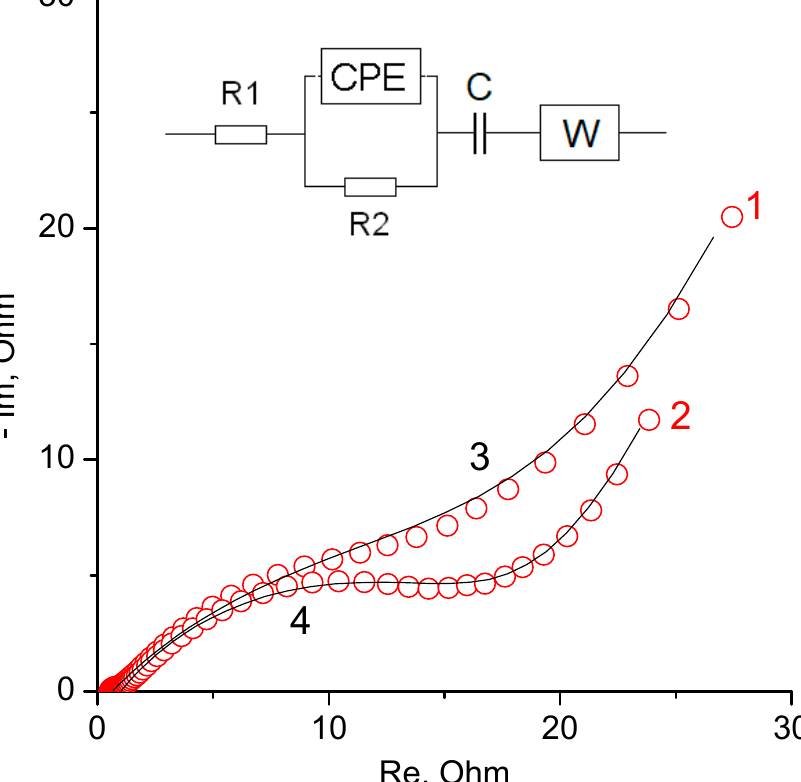
Figure 13. Equivalent electrical circuit and Nyquist diagram for experimental spectra (red circles) and for spectra obtained by fitting an equivalent electrical circuit (black lines). 1, 3—for rGO/TiO 2 15% composite; 2, 4—for rGO/TiO 2 30% composite.